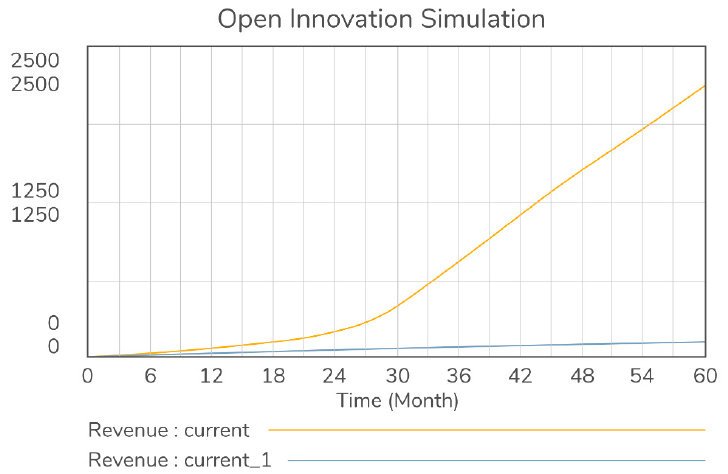
Figure 5. The OI simulation with OI variables (current) and without OI variables (current_1).